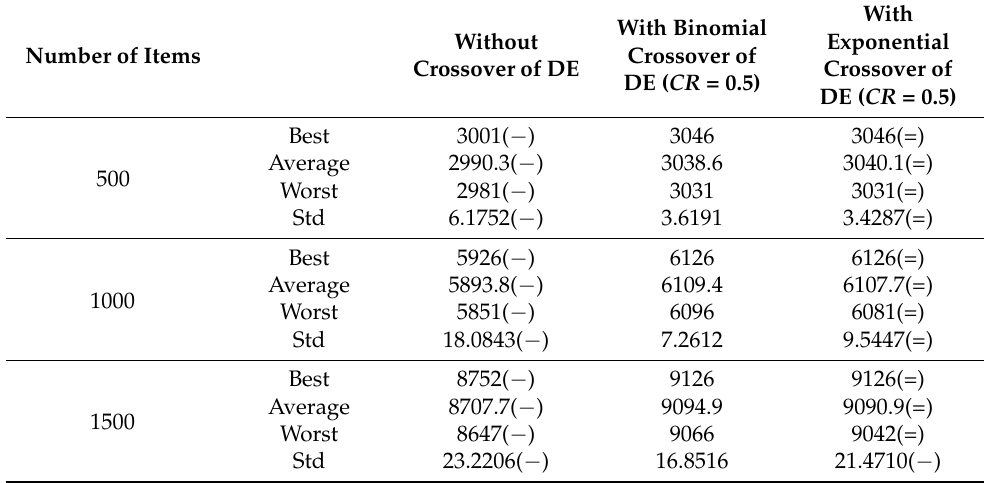
Table 4. Experimental results of QDGWO algorithm without crossover of DE, with binomial crossover of DE, and with exponential crossover of